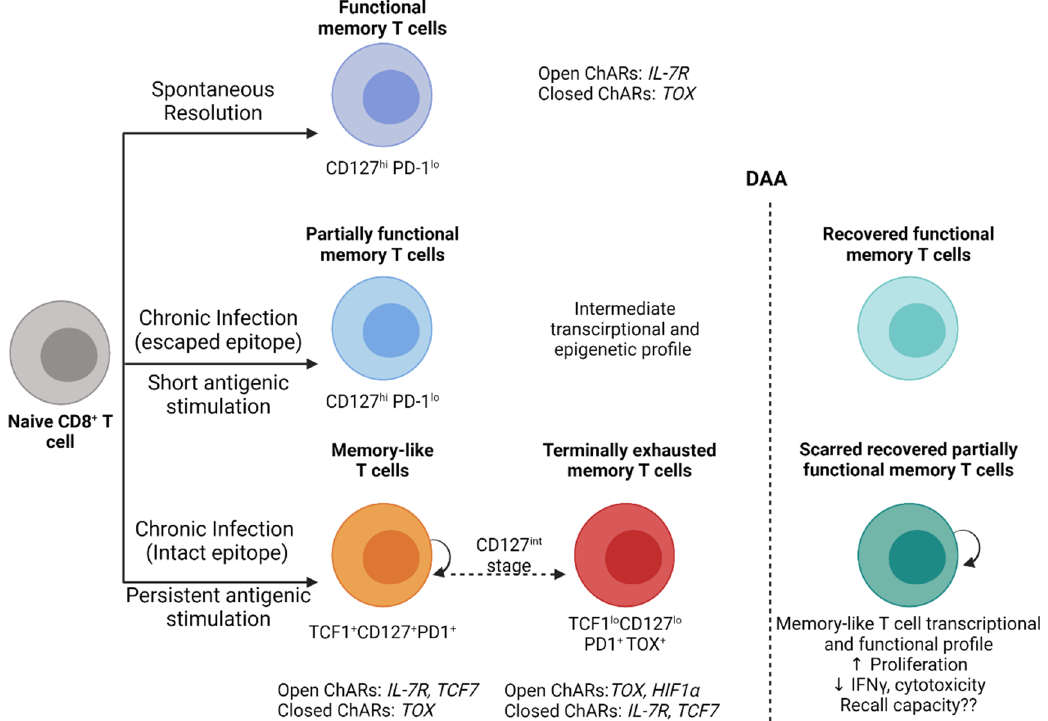
Figure 1. Model of CD8+ T cell exhaustion and functional restoration during HCV infection and DAA therapy. Following the spontaneous clearance of acute HCV infection, functional memory CD8 + T cells (CD127 + PD-1 lo ) develop and maintain epigenetic signatures with open chromatin accessibility regions (ChARs) that facilitate rapid recall responses. In individuals who develop chronic infection, with CD8+ T cells targeting escaped epitopes and exposed to a short period of antigenic stimulation recover an intermediate phenotype, transcription and an epigenetic profile that resembles to a great extent functional memory T cells. CD8+ T cells targeting intact epitopes remain persistently stimulated by antigens and develop into memory-like T cells (TCF1 + CD127 + PD1 + ) that retain their proliferative capacity and develop into terminally exhausted memory T cells (TCF1 lo CD127 lo PD1 + TOX + ) through a CD127 int stage. These exhausted CD8+ T cells exhibit transcriptional and epigenetic signatures similar to exhaustion profiles reported in HIV, LCMV and cancer. DAA-mediated virus clearance and the removal of persistent antigenic stimulation reverses most of the functional and epigenetic changes in CD8+ T cells targeting escaped epitopes. In contrast, CD8+ T cells targeting intact epitopes maintain an exhaustion scar and only partially recover antiviral functions with restored proliferation but not cytokine production or cytotoxicity. These exhaustion scars are long-lived for up to 3 years post-virus clearance. The recall capacity of recovered T cells upon HCV reinfection remains unknown but data from the LCMV model suggest that it will be compromised. Created with BioRender.com.